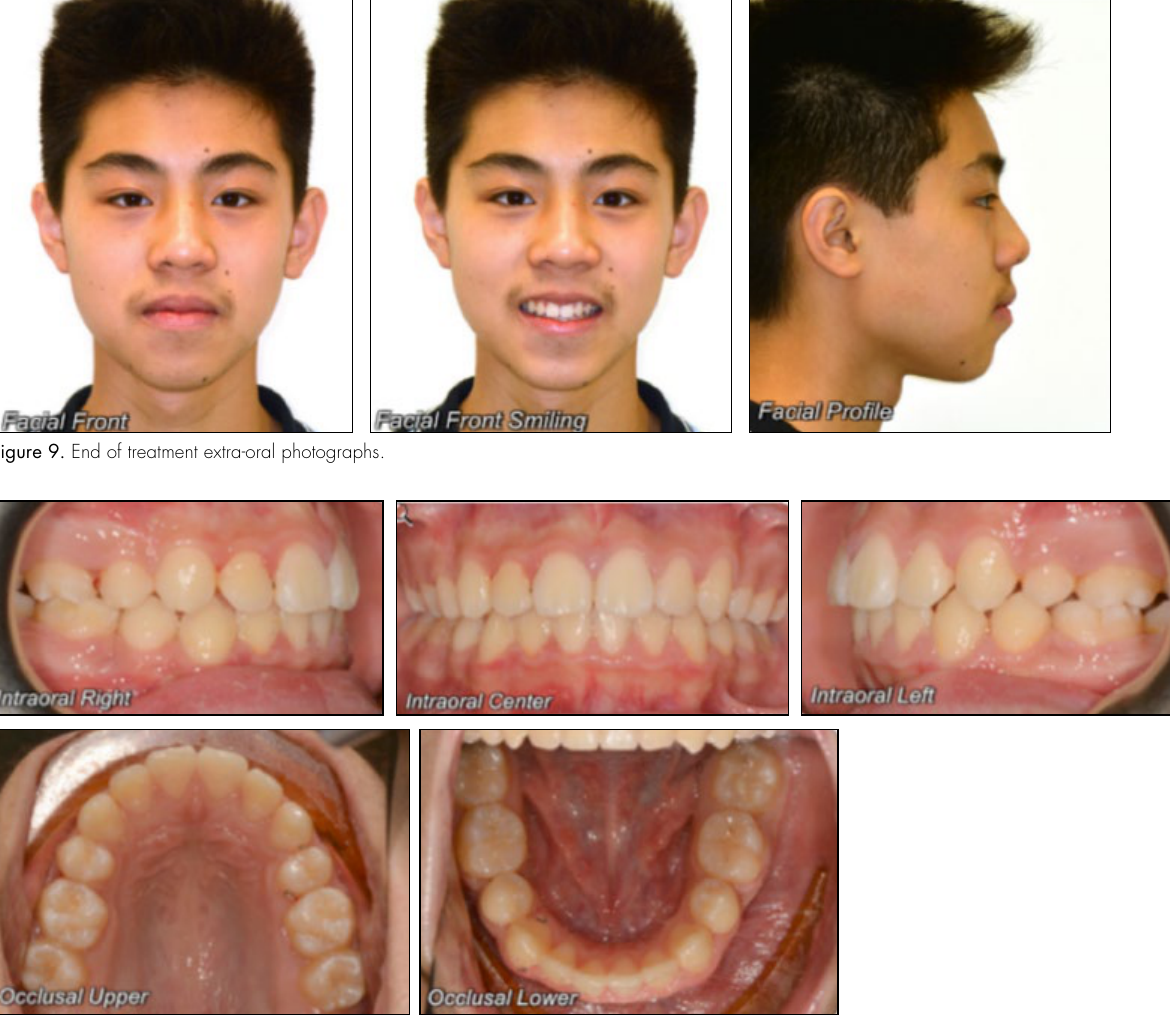
Figure 10. End of treatment intraoral